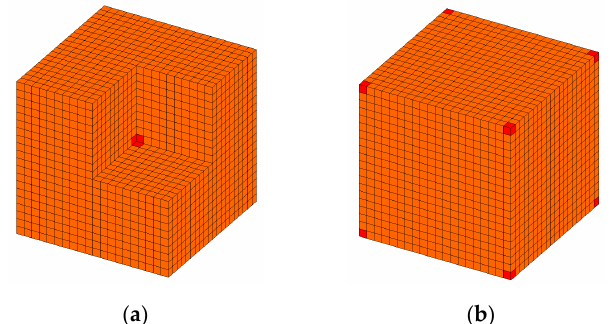
Figure 6. Initial guess design of the representative volume element: ( a ) initial guess design 1 (hide the upper right front part); ( b ) initial guess design 2.